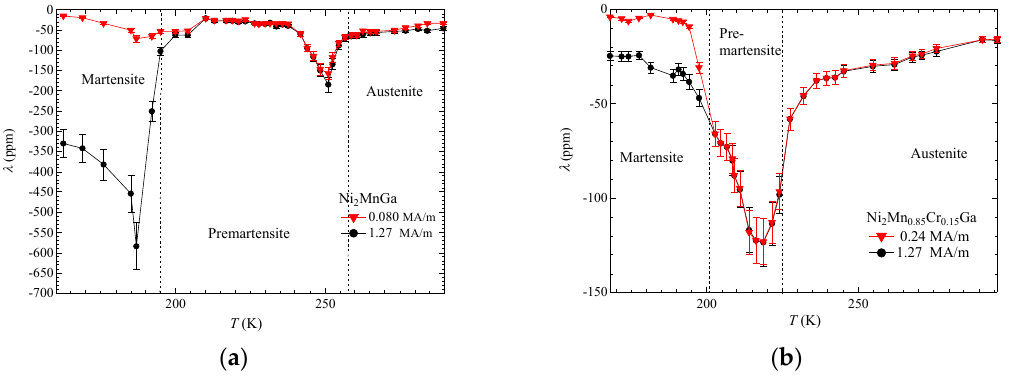
Figure 6. Temperature dependence of the magnetostriction λ for the ( a ) x = 0.00 alloy; and ( b ) x = 0.15 alloy.